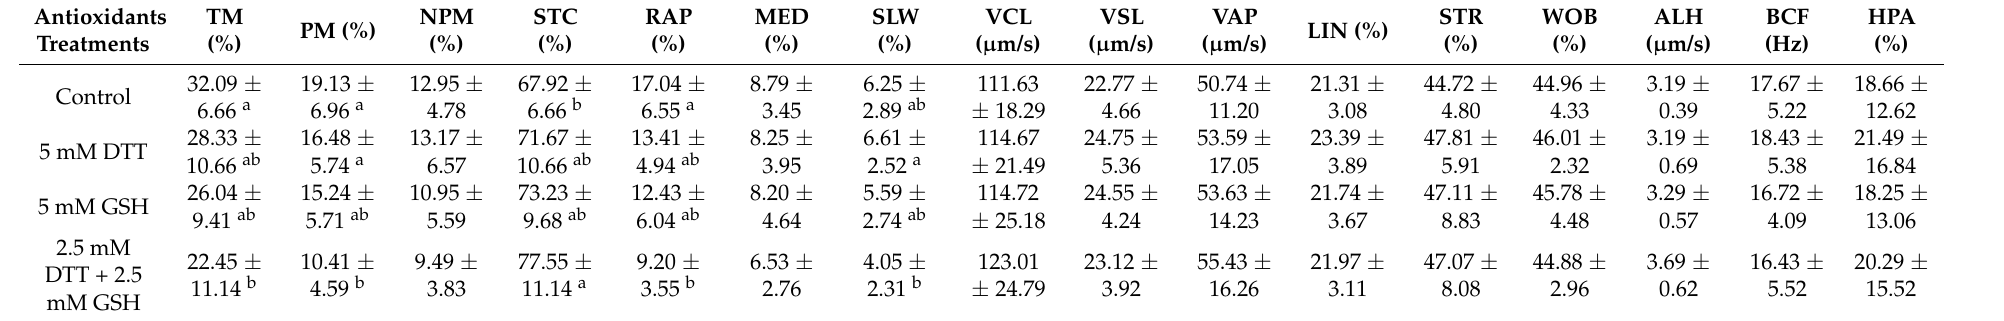
Table 6. Characterization of sperm motility and velocity traits of frozen-thawed Large White boars’ semen supplemented with antioxidants (mean ±